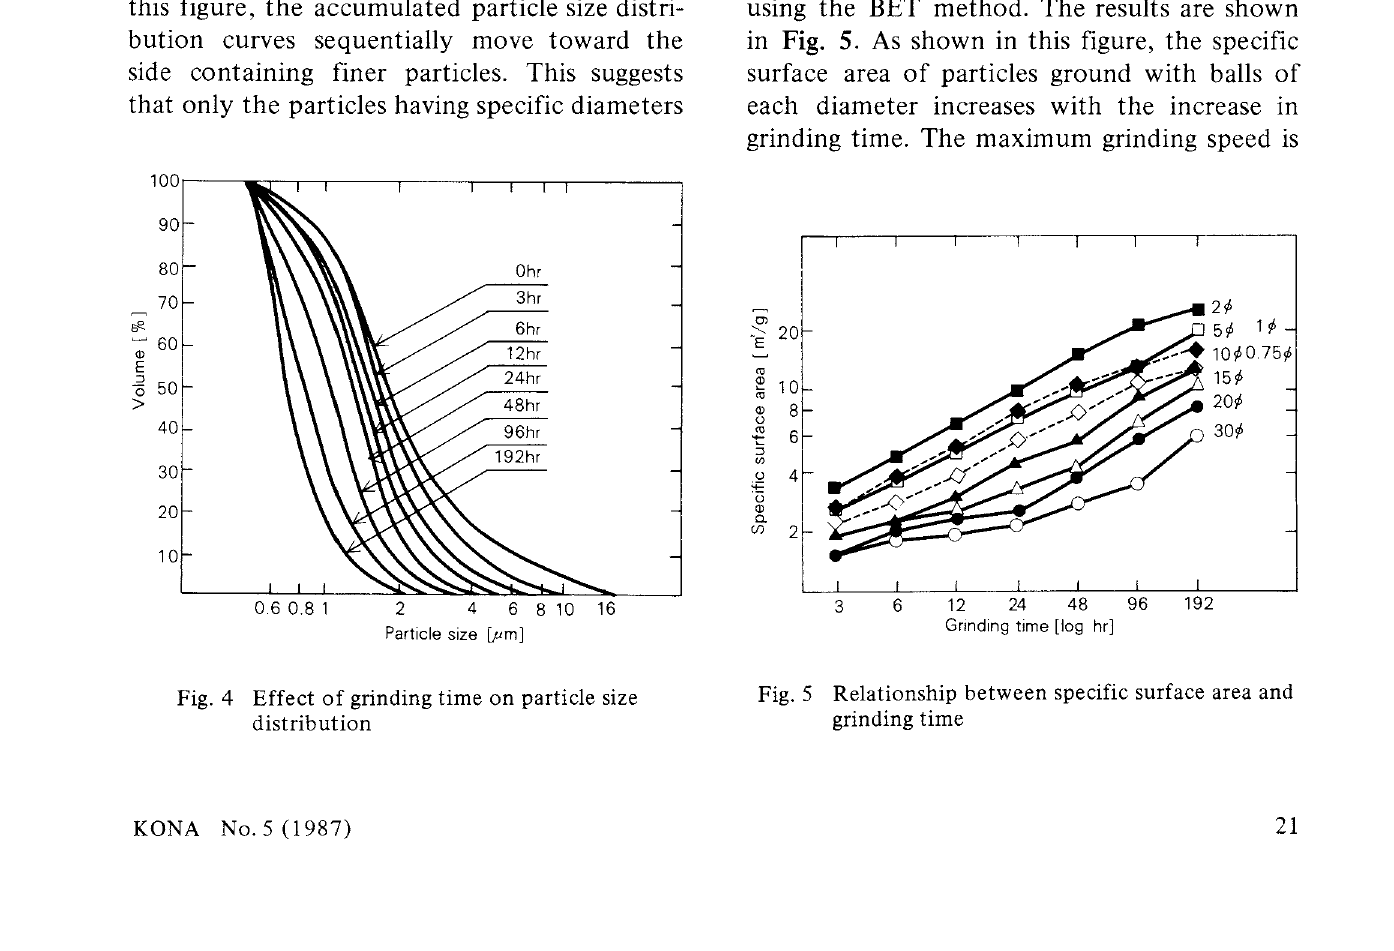
Fig. 4 Effect of grinding time on particle size distribution